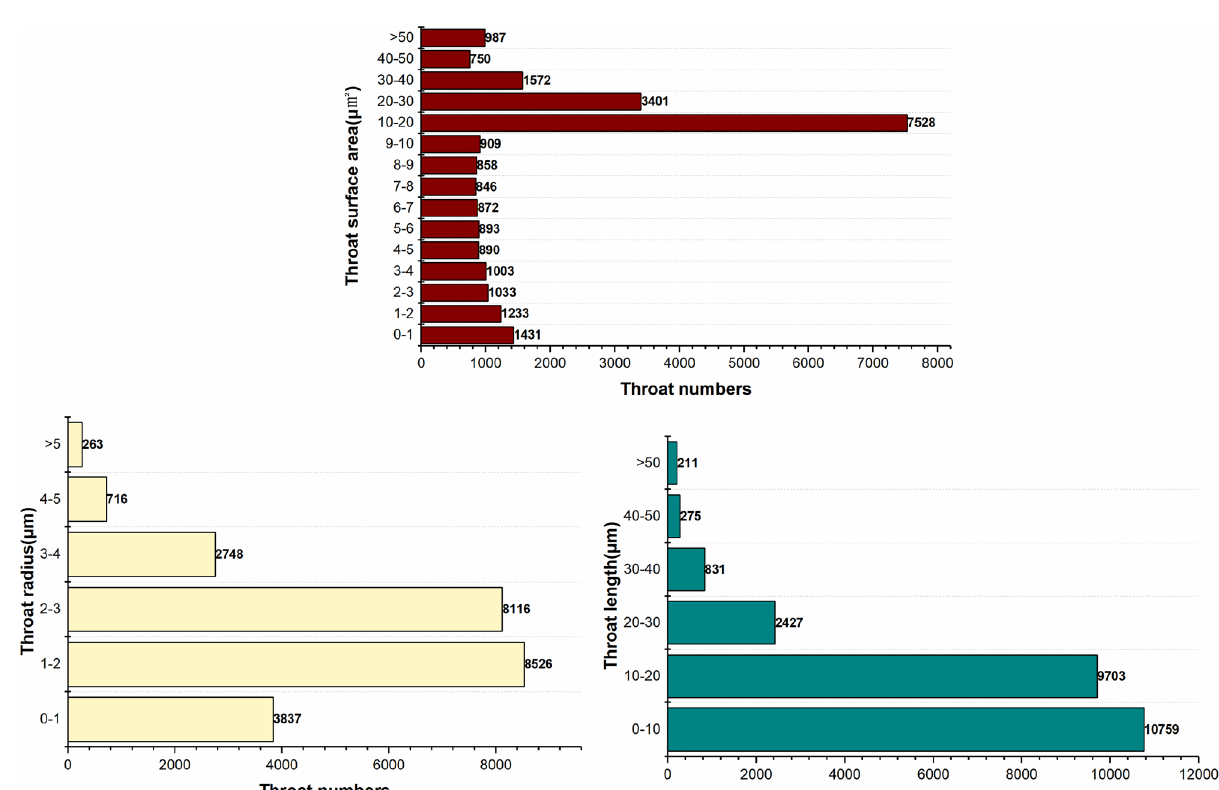
Figure 12. Throat quantitative parameter statistics of pore network